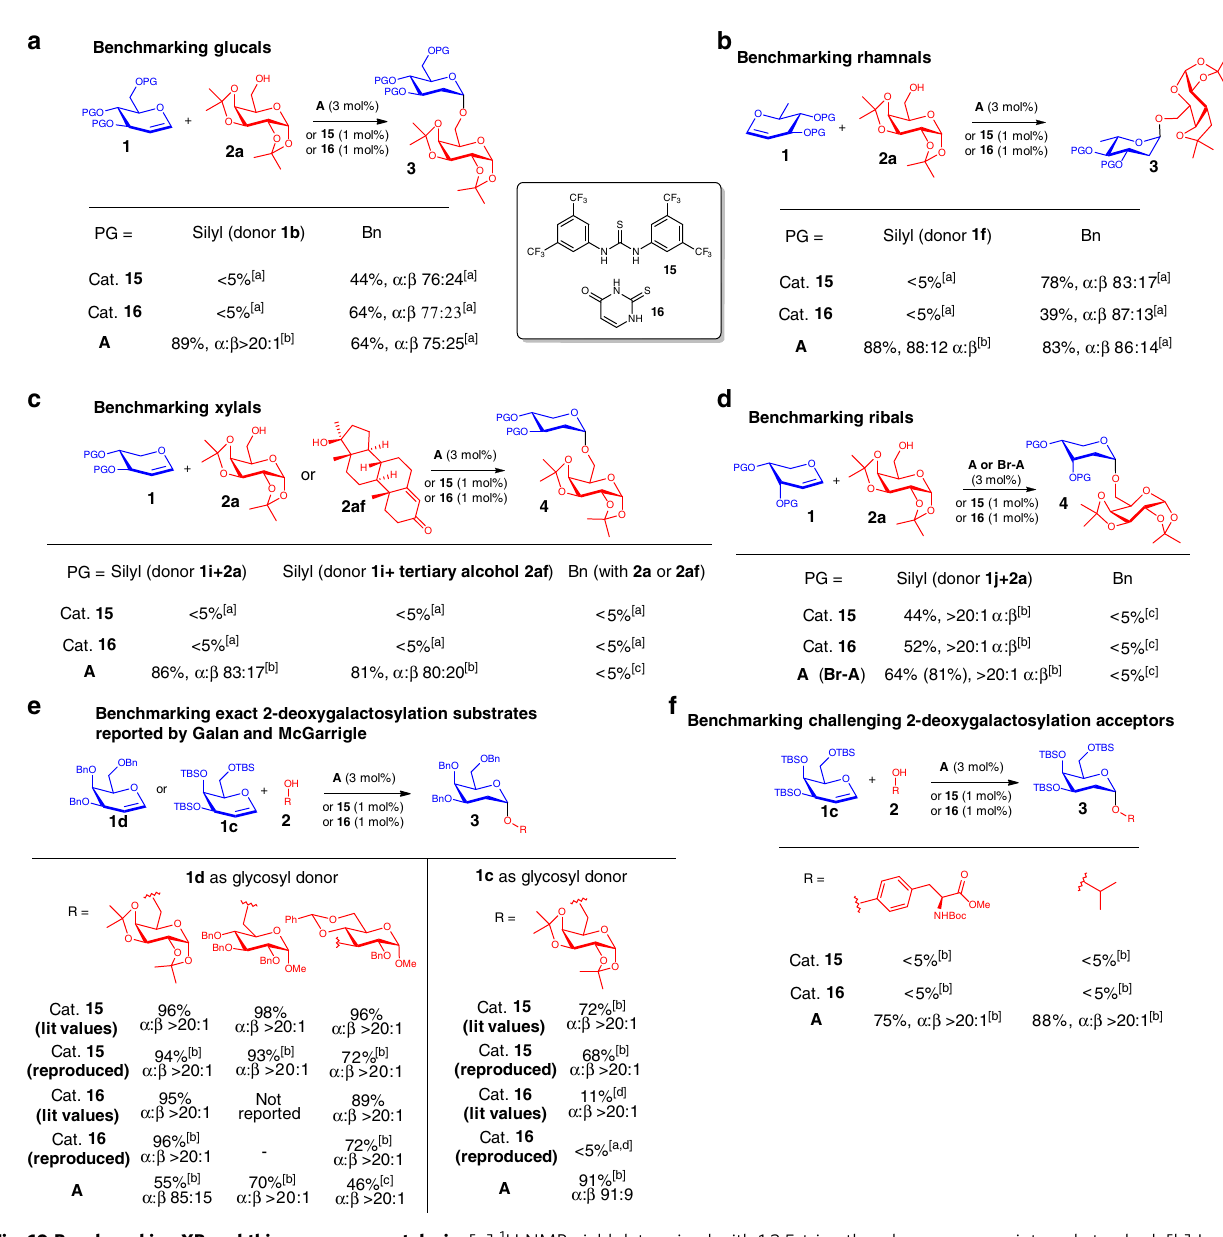
Fig. 10 Benchmarking XB and thiourea organocatalysis. [a] 1 H NMR yield determined with 1,3,5-trimethoxybenzene as an internal standard. [b] Isolated yields after fl ash column chromatography. [c] A mixture with inseparable Ferrier-type product impurity was obtained after fl ash chromatography puri fi cation, the yield was calculated by 1 H NMR analysis. [d] Reaction time was 48 h, literature gave 68% yield with 2-methyl THF as solvent at 83 °C re fl uxing temperature. a Benchmarking glucals, b Benchmarking rhamnals, c Benchmarking xylals, d Benchmarking ribals, e Benchmarking reported 2- deoxygalactosylation substrates, f Benchmarking challenging 2-deoxygalactosylation